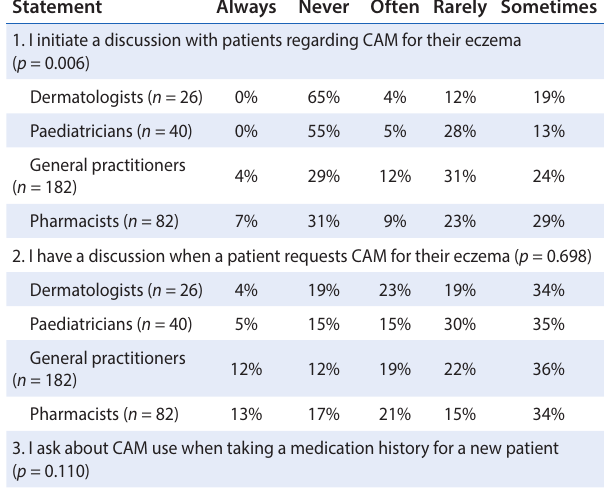
Figure 1: Percentage of healthcare professionals that recommend CAM for eczema ( p <